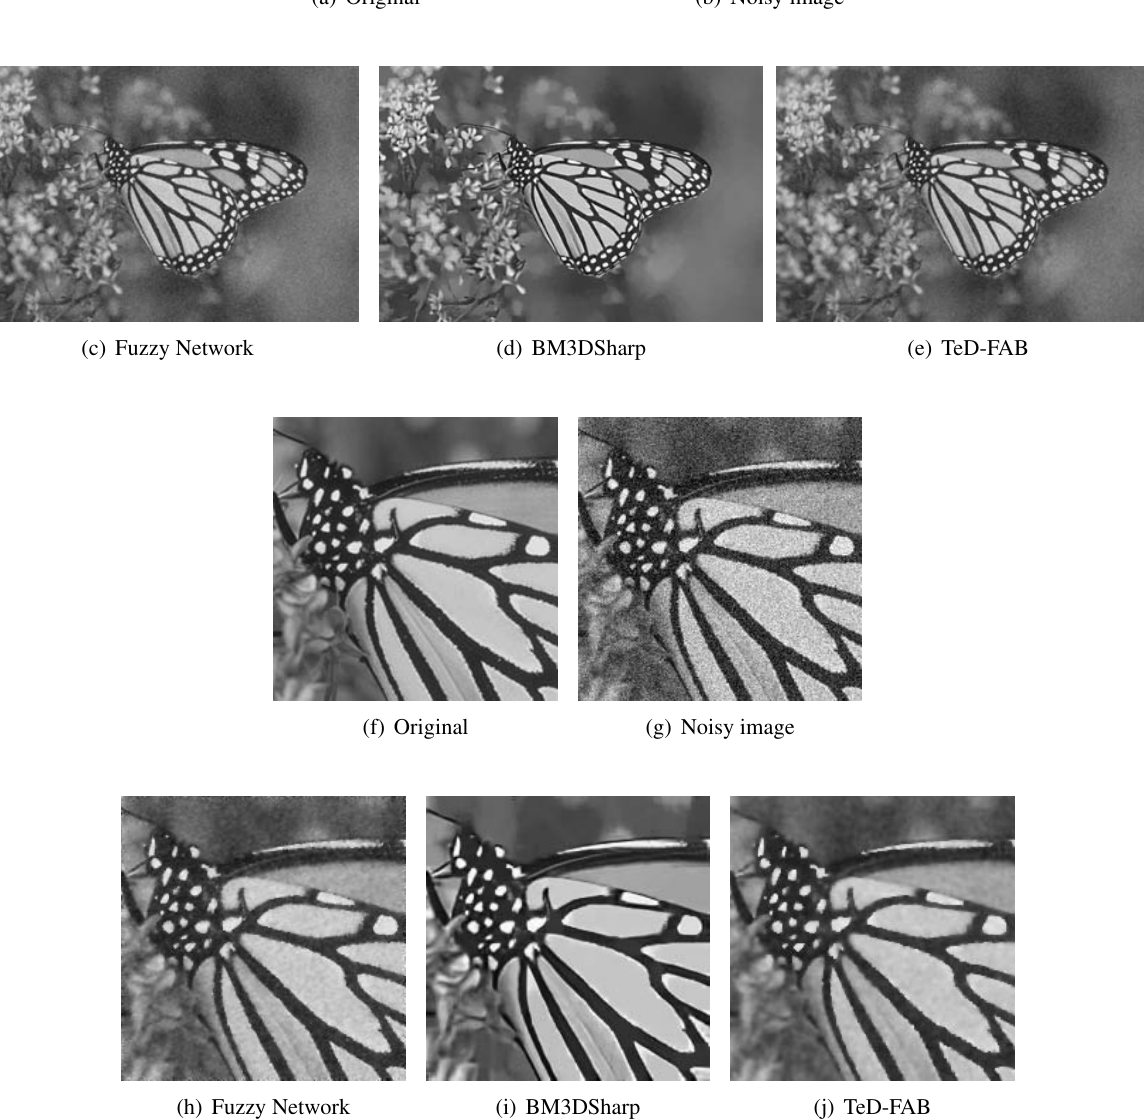
Fig. 11 Results of smoothing & sharpening with different methods an image corrupted by Gaussian noise with σ =